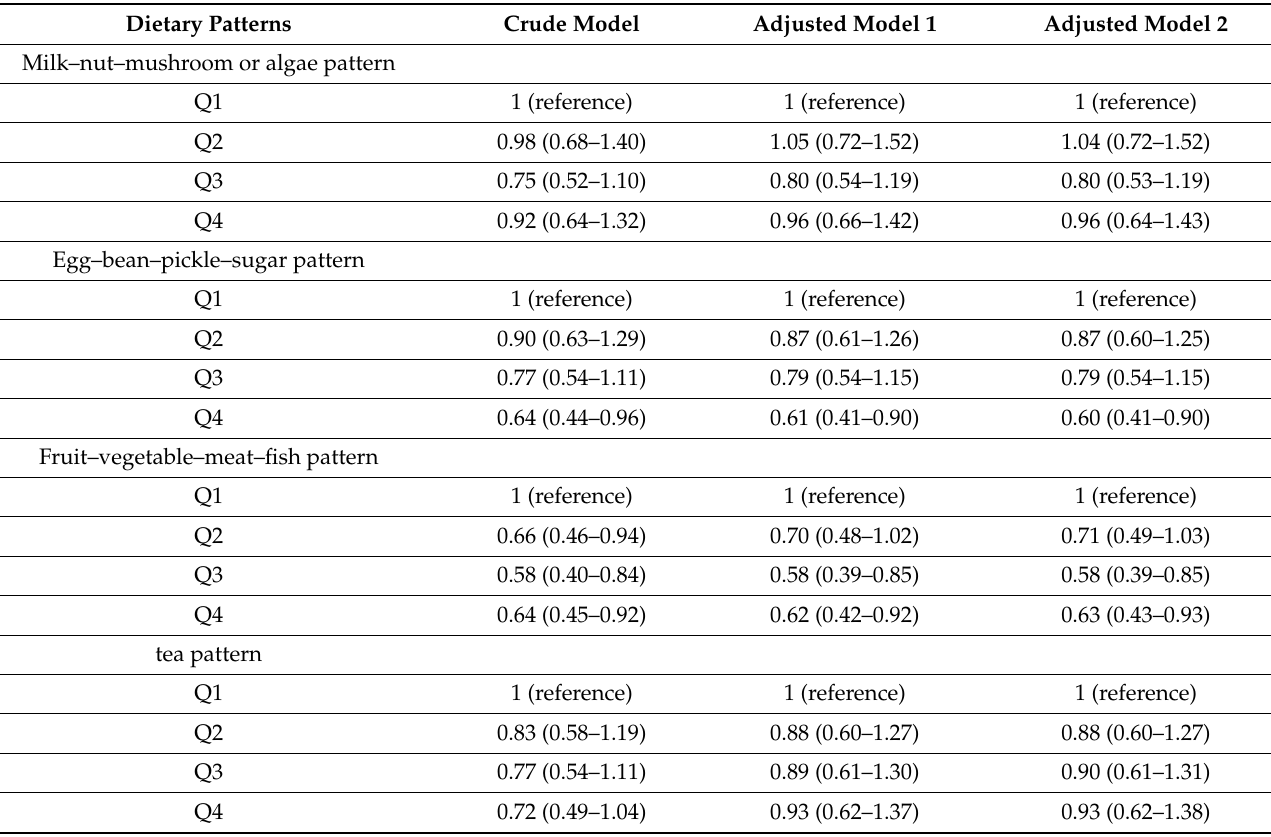
Table 3. Logistic regression analysis between different dietary pattern score and the incidence of frailty. Dietary Patterns Crude